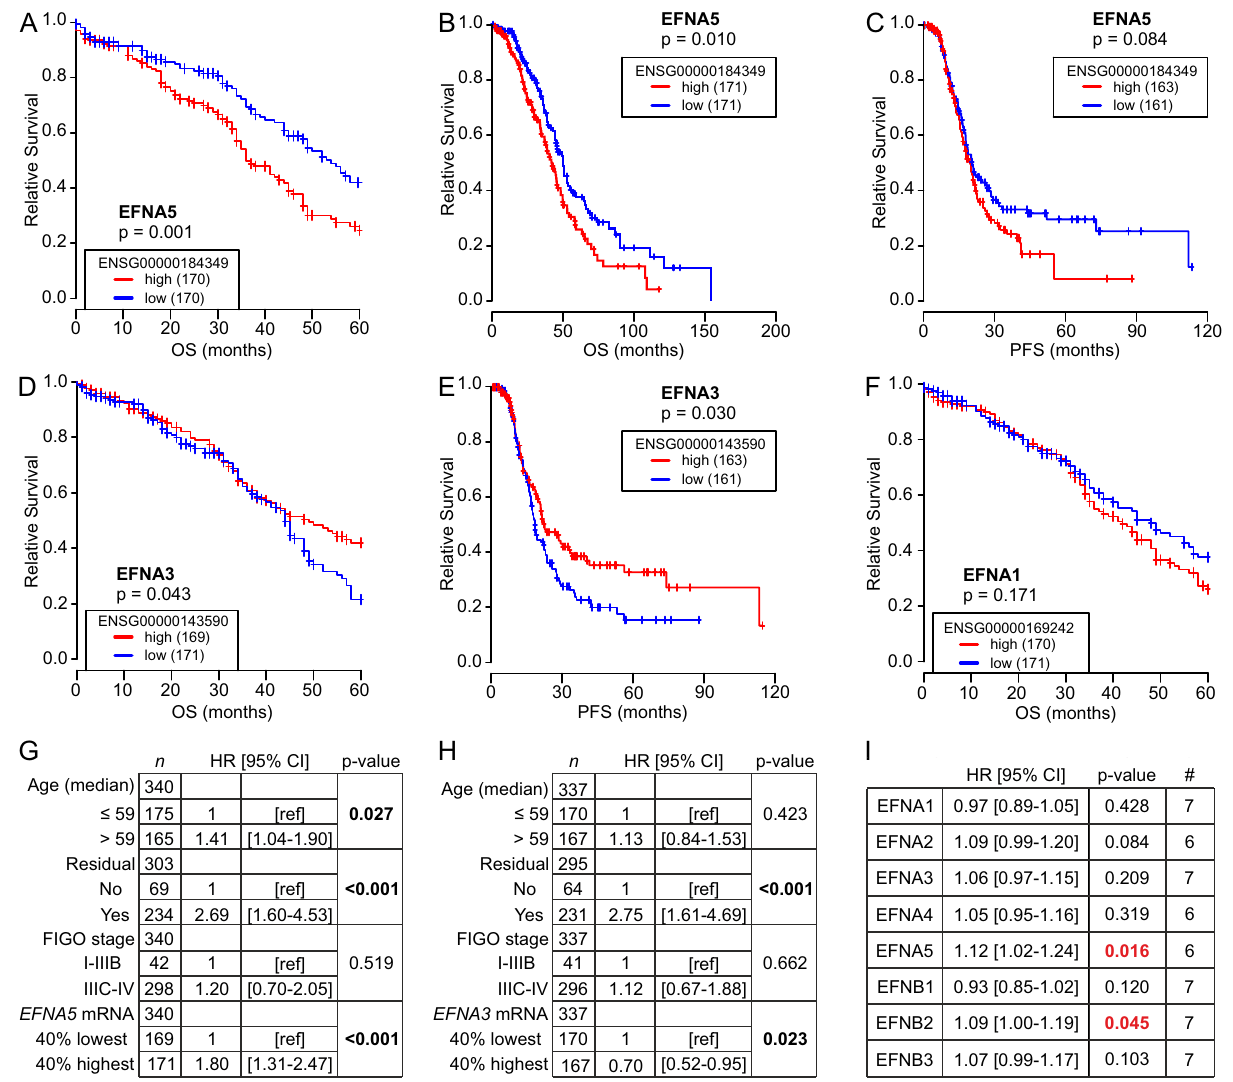
Figure 1. Ephrin and Eph gene expression are diversely associated to survival in HGSC. ( A – F ) Kaplan–Meier survival curves illustrate the 5-year and 13-year overall survival (OS) or the progression-free survival (PFS) of patients with high or low (top 40% vs bottom 40%) EFNA5 ( A : 5-y OS, B : 13-y OS, C : PFS), EFNA3 ( D : 5-y OS, E : PFS), and EFNA1 ( F : 5-y OS) in TCGA HGSC dataset. Logrank test was used. ( G , H ) Multivariate analysis results for EFNA5 ( G ) and EFNA3 ( H ) OS associations when considering the variables age at diagnosis (median cutoff of 59 years), residual tumor after surgery (no vs yes) and FIGO stage (I–IIIB vs IIIC–IV). Cox regression was used. HR [95% CI] = hazard ratio with 95% confidence interval. ( I ) Overall hazard ratios and p values from the Cox regression tests performed to analyze ephrin survival associations in HGSC using the curatedOvarianData database. Significant associations between poor OS and high ligand expression are indicated in red. # = number of included